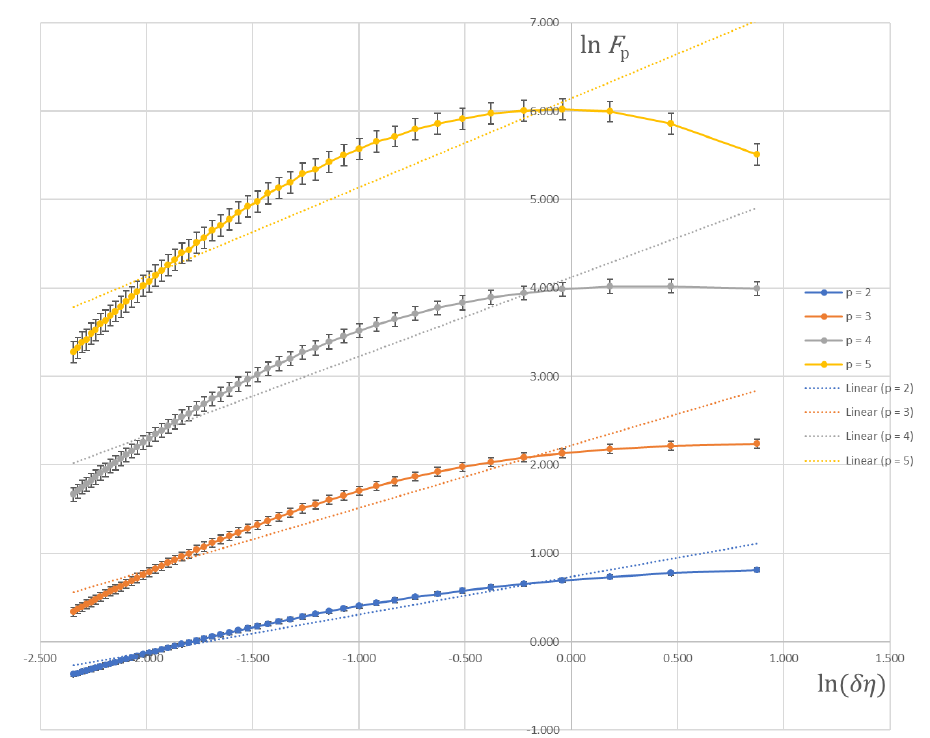
Figure 1: Plots of ln F p vs. ln ( δη ) (experimental values)